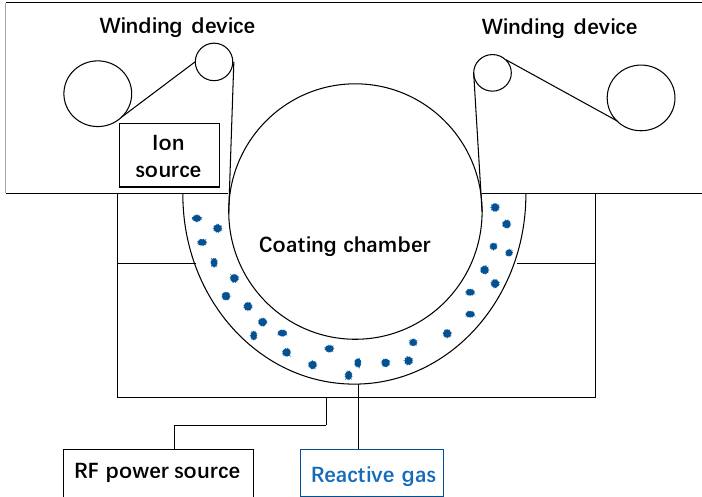
Figure 1. The working principle of a PECVD system.